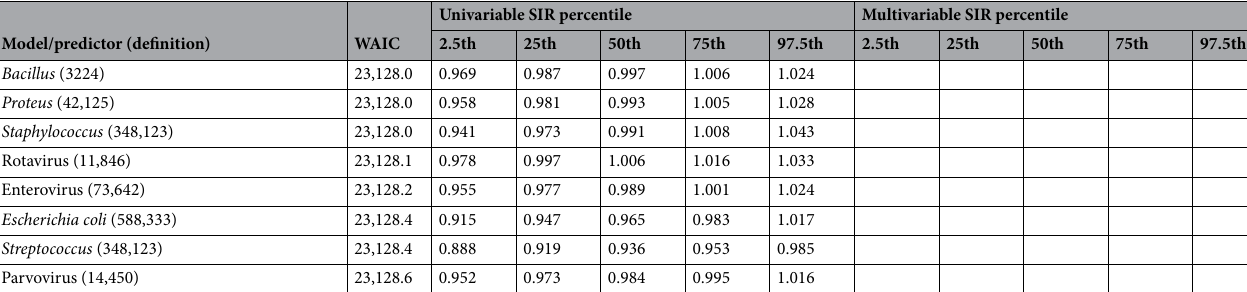
Table 1. Comparison of hierarchical models with different temporal structures, adjustment factors and covariates. In the Bayesian model framework, a decrease in the Watanabe-Akaike information criterion (WAIC) is an indication of improved predictive accuracy. The simplest model in the table is the linear time model which consists of the spatially structured and unstructured term (Besag-York-Mollie model) and a linear time trend. A random walk of order 1 (temporally structured effect) and a seasonal cycle with length 12 months are sequentially added. The latter model shows the lowest WAIC and is therefore used as the base model. The WAICs for the adjustment factors (percentage of population age 0–4 and East Asians) were only listed for completeness, but not used as a selection criterion. In all models listed under ‘Main regression model’, candidate variables were added to the adjusted base model one-by-one and listed by ascending WAIC within the variable category. Variables which, when added to the adjusted base model, resulted in a model with a lower WAIC (> 1 change), were included in a preliminary multivariable model. These variables were further subject to selection through backward elimination based on them increasing the multivariable WAIC. The percentile landmarks of the posterior coefficients of the fixed effects for all univariable models (‘Screening’) and that were included in the multivariable model are presented with standardized incidence rate associated with a 1 standard deviation change in the predictor. The original units for each variable are indicated for general information. FSA forward sortation area, ICD international classification of disease, SIR standardized incidence rate, WAIC Watanabe-Akaike Information Criterion. † Improved (i.e. lowered) WAIC by >1 over